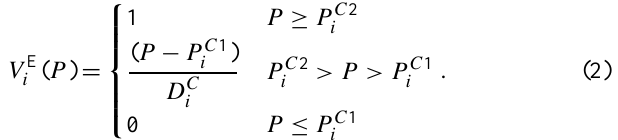
Figure 1. Vegetation–precipitation stability diagram ( V E for two hypothetical plant types i = 1 , 2 after Claussen et al. (2013). Full lines depict the equilibrium curves for vegetation cover V E ( P E ) for plant type 1 which is sensitive (red) and for i plant type 2 which is resilient (green) to changes in precipita- tion. Dashed blue lines show hypothetical equilibrium precipitation curves P E ( V E ) for different time slices (4500, 4900, 5300, 5700, i 6100, and 6500 yearsBP, from left to right). Intersections between the two types of curves indicate equilibrium coupled states which can be stable or